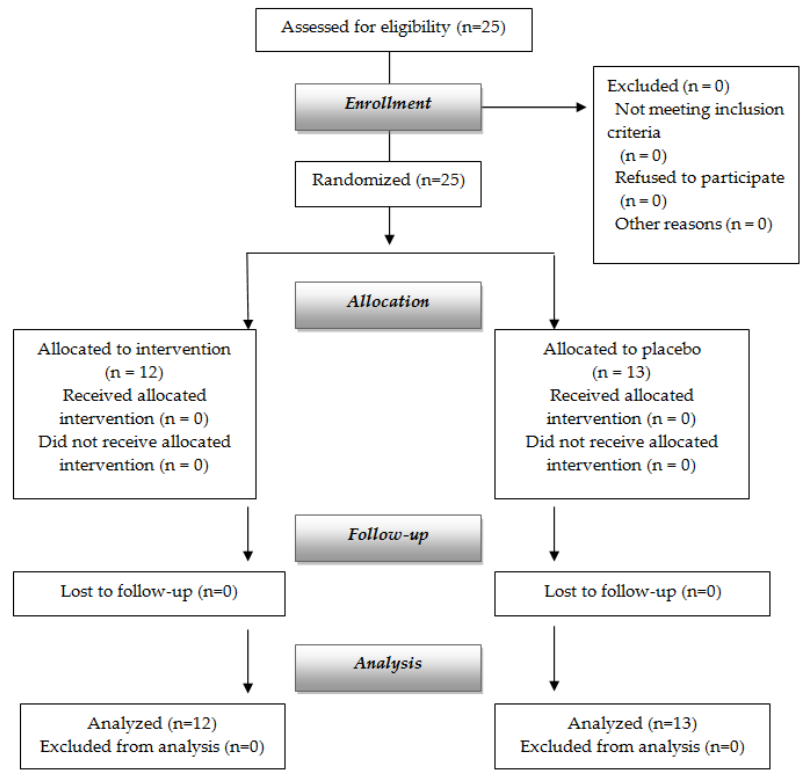
Figure 1. Flow chart of the study.